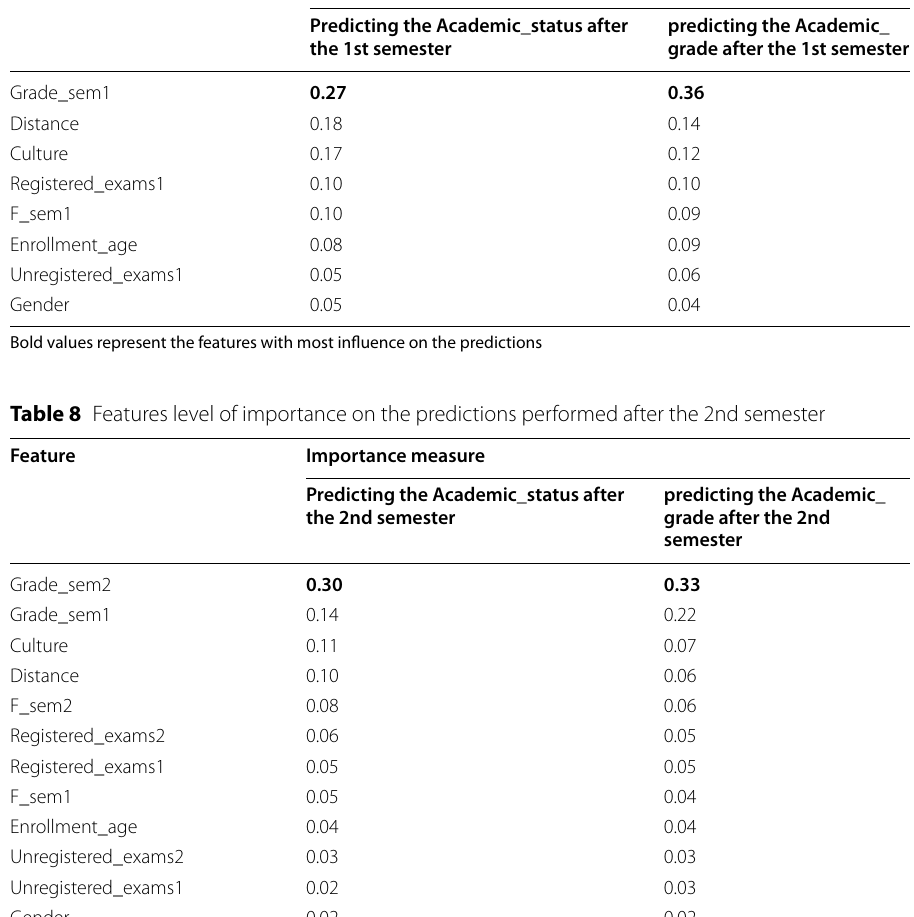
Table 7 Features level of importance on the predictions performed after the 1st semester Feature